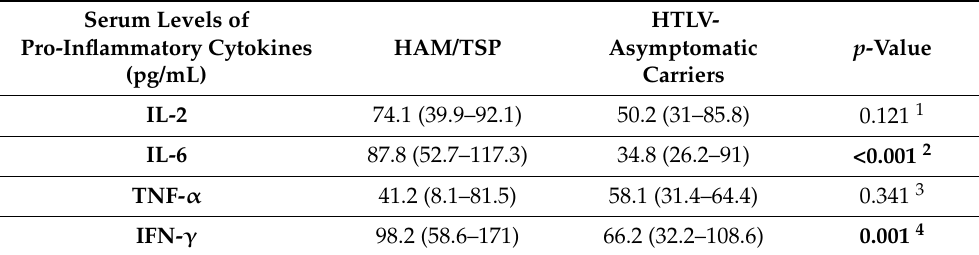
Table 3. Comparison between serum levels of proinflammatory cytokines (IL-2, IL-6, TNF- α and IFN- γ ) between the HAM/TSP patients and HTLV-asymptomatic carriers.